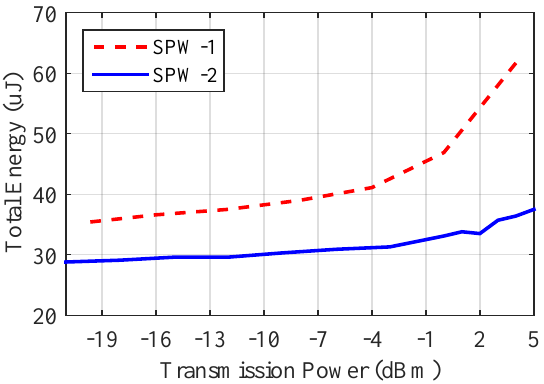
Figure 8. Energy consumption for the transmission of a triple BLE